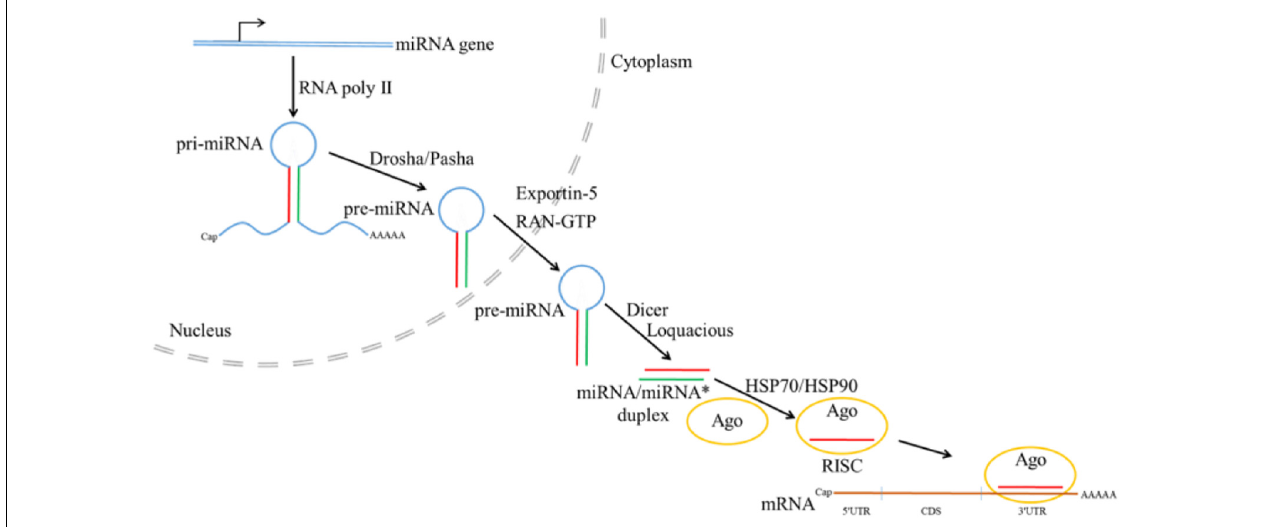
FIGURE 8 | Canonical microRNA biogenesis pathway in Drosophila (the figure is summarized from Bartel, 2004; Denli et al., 2004; Kim et al., 2009; Iwasaki et al., 2010; Cao et al., 2017; Qu et al.,